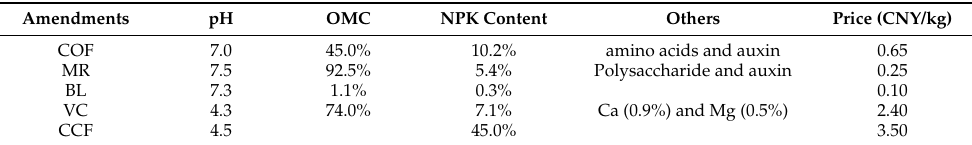
Table 1. The pH, composition and price of each soil amendments used in this study.